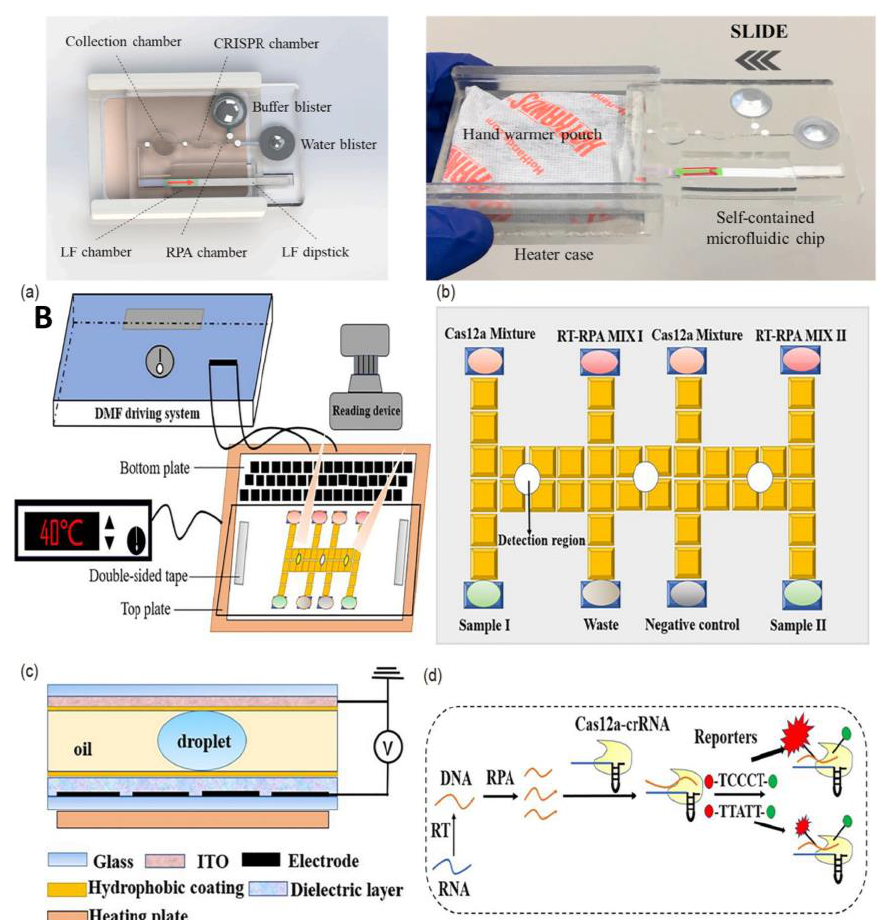
Figure 9. ( A ) Schematic diagram of a self-contained microfluidic system for the detection of SARS-CoV-2 in clinical samples. Reproduced with permission from Li, Z., Biosens. Bioelectron. , published by Elsevier, 2022 [64]. ( B ) Schematic drawings of an automated nucleic acid detection platform using digital microfluidics with an optimized Cas12a system. ( a ) Illustration of the RCD platform. ( b ) Plan view of. ( c ) Side view of the chip. ( d ) Schematic illustration of the RPA-Cas12a- crRNA recognizing target and cleaving the reporter. Reproduced with permission from Sun, Z., Sci. China Chem. , published by Springer, 2022 [66].